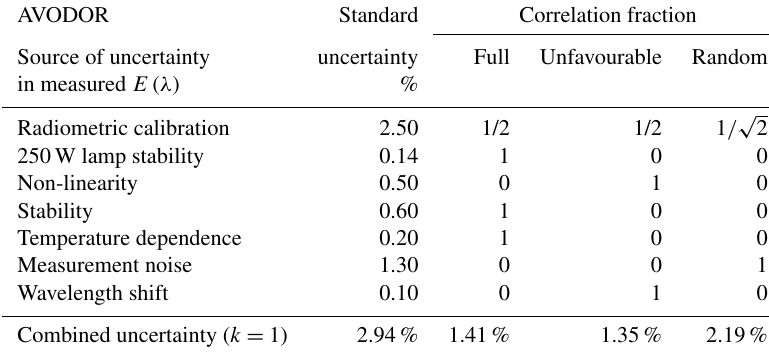
Table 3. Uncertainties in the measurement for AVODOR spectroradiometer.